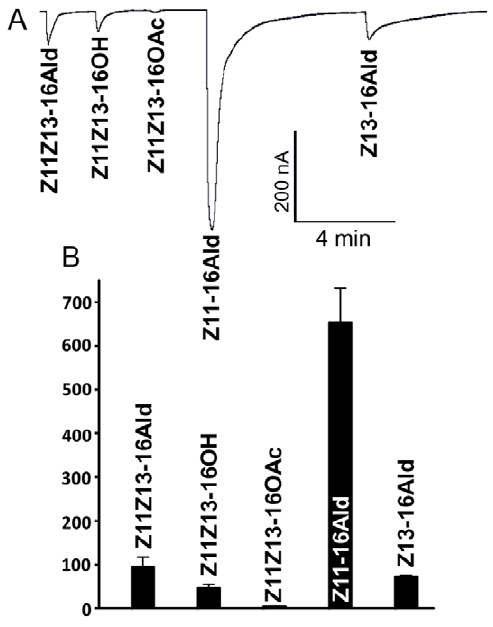
Figure 3. Responses elicited by constituents of the pheromone gland on AtraOR3 N AtraOrco-expressing oocytes. (A) Trace generated at 100 m M highlighting a specific response to Z11-16Ald, a gland constituent of unknown function. (B) Quantification of current responses, n =4.